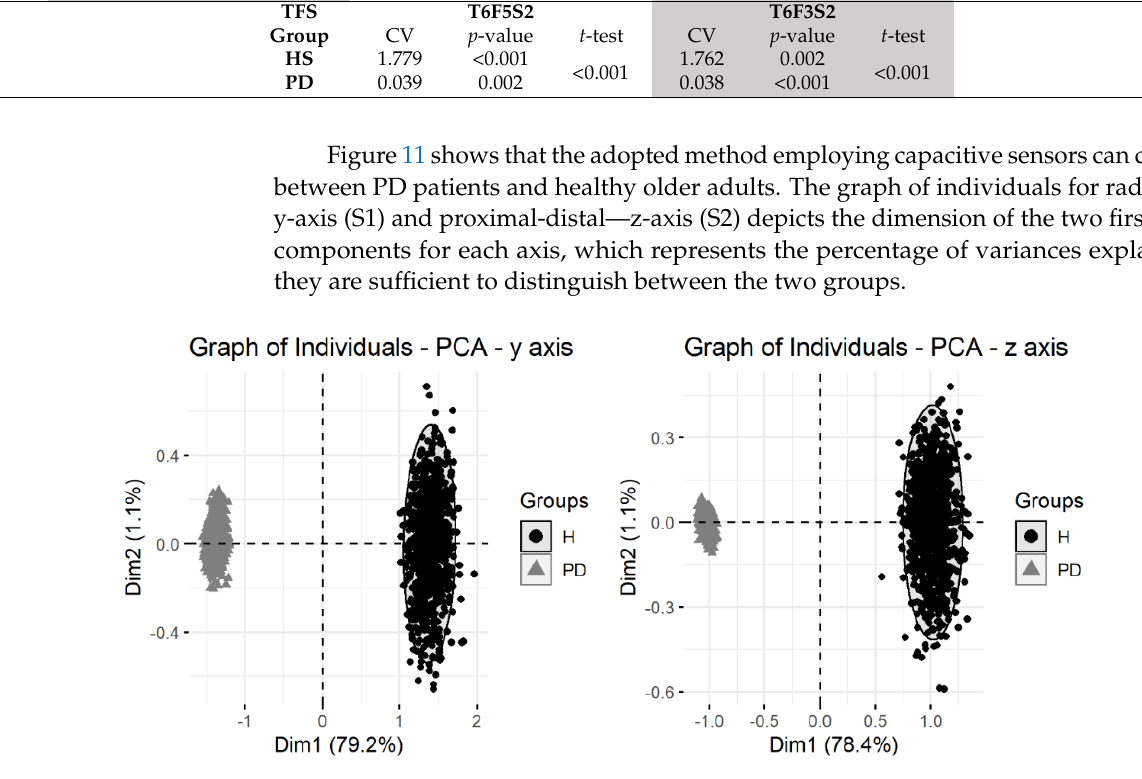
Figure 11. Graph of individuals for radial-ulnar—y − axis (S1) and proximal-distal—z − axis